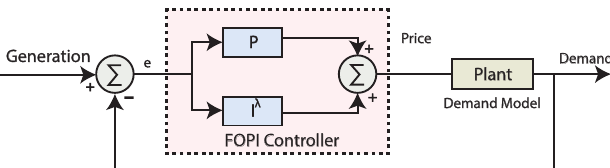
Figure 1. Block diagram of simulations using FOPI controller in closed-loop elastic demand control.